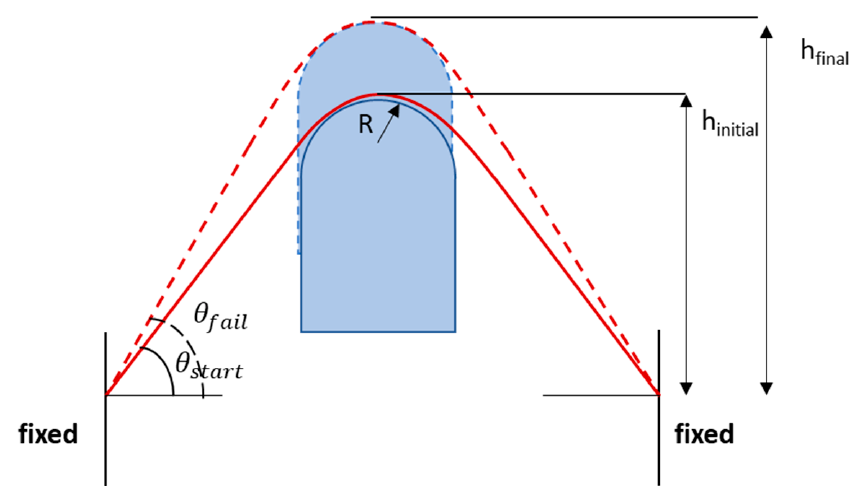
Figure 3. Transverse loading schematic.